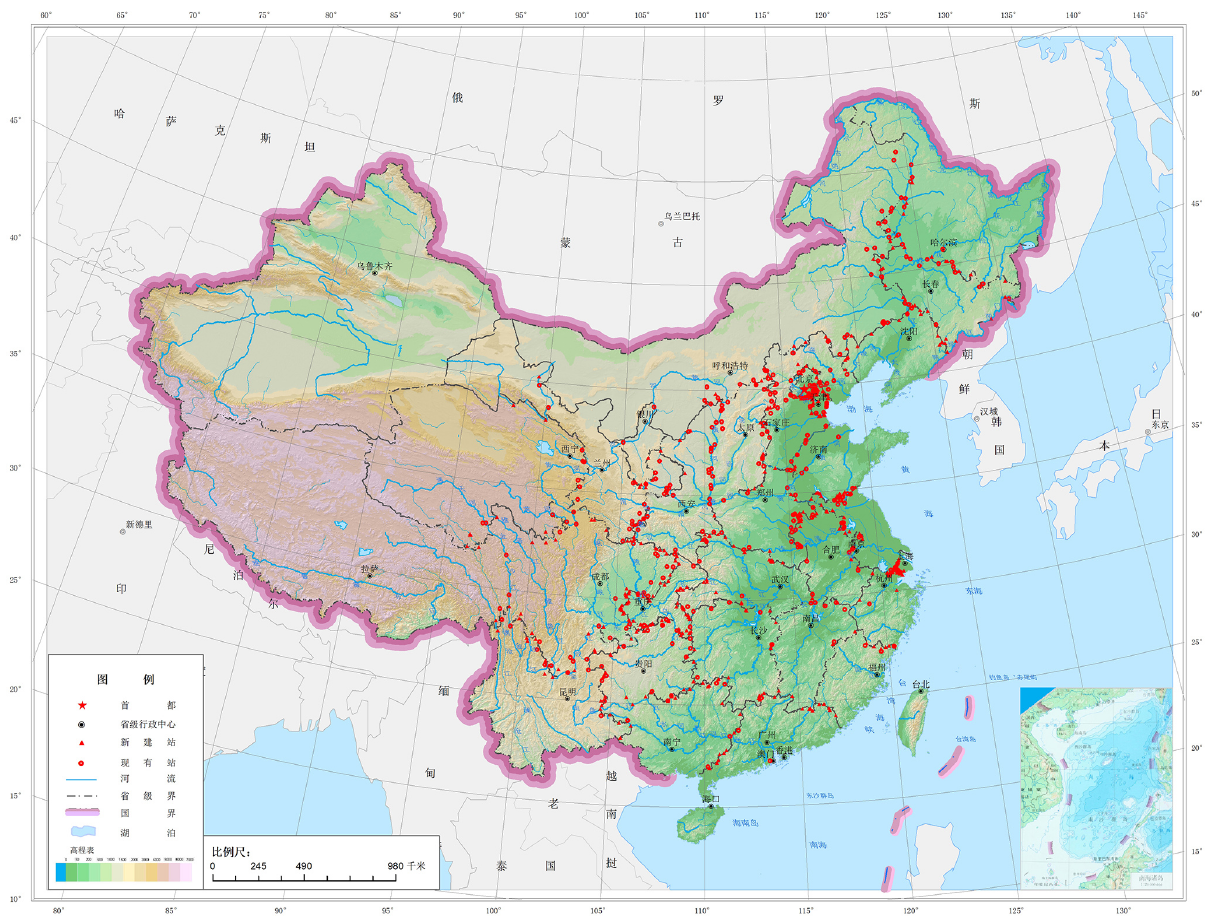
Figure 3. Sketch map of the planned hydrological monitoring stations for interprovincial boundary